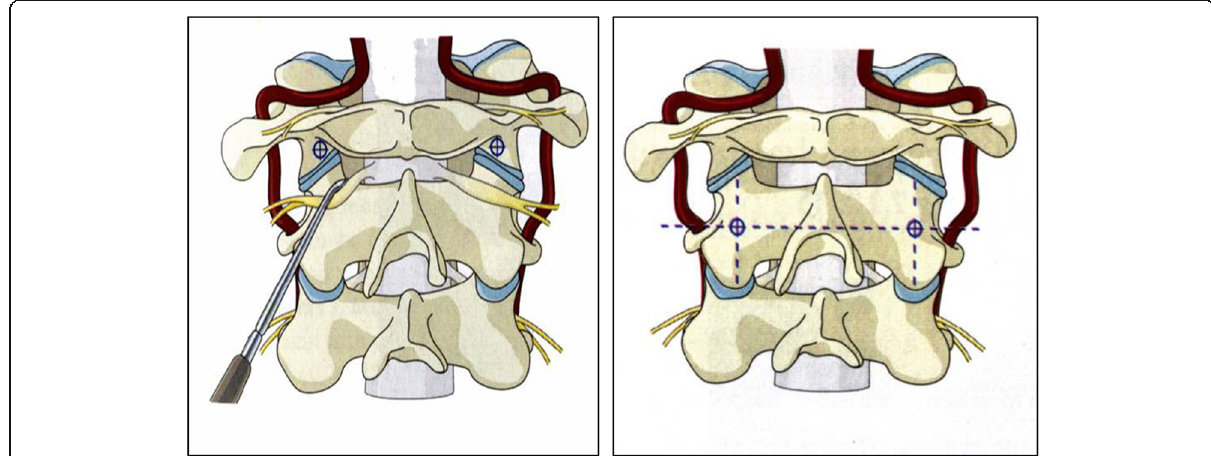
Fig. 1 Identification of the entry point of C1 – C2 Harms technique